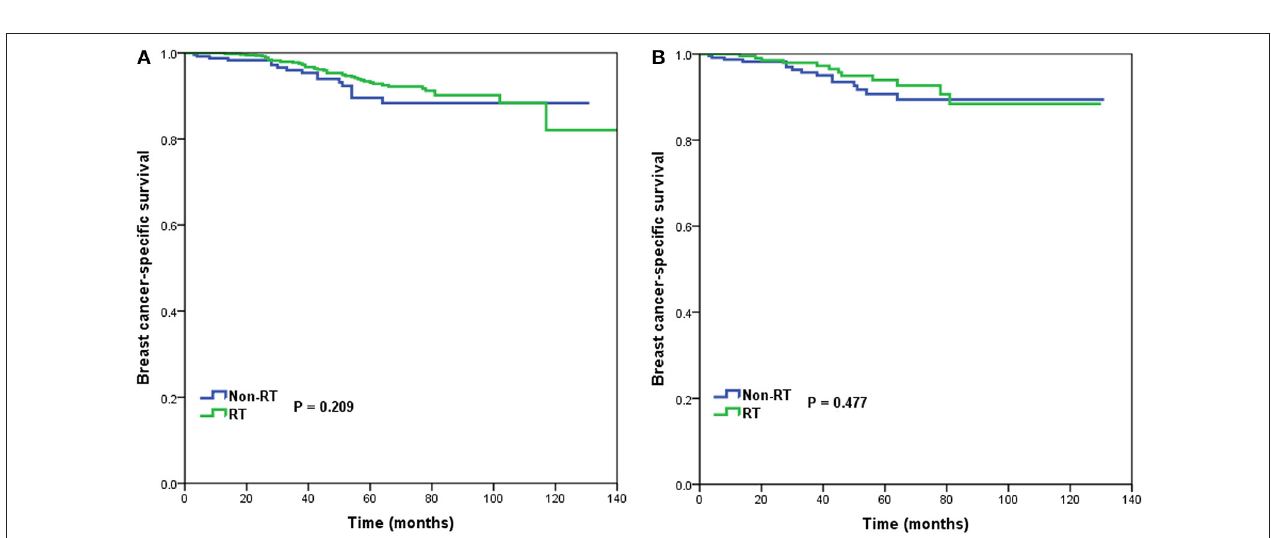
FIGURE 5 | Breast cancer-specific survival in patients who had or did not have postoperative radiotherapy in the high-risk group before (A) and after (B) propensity score matching.